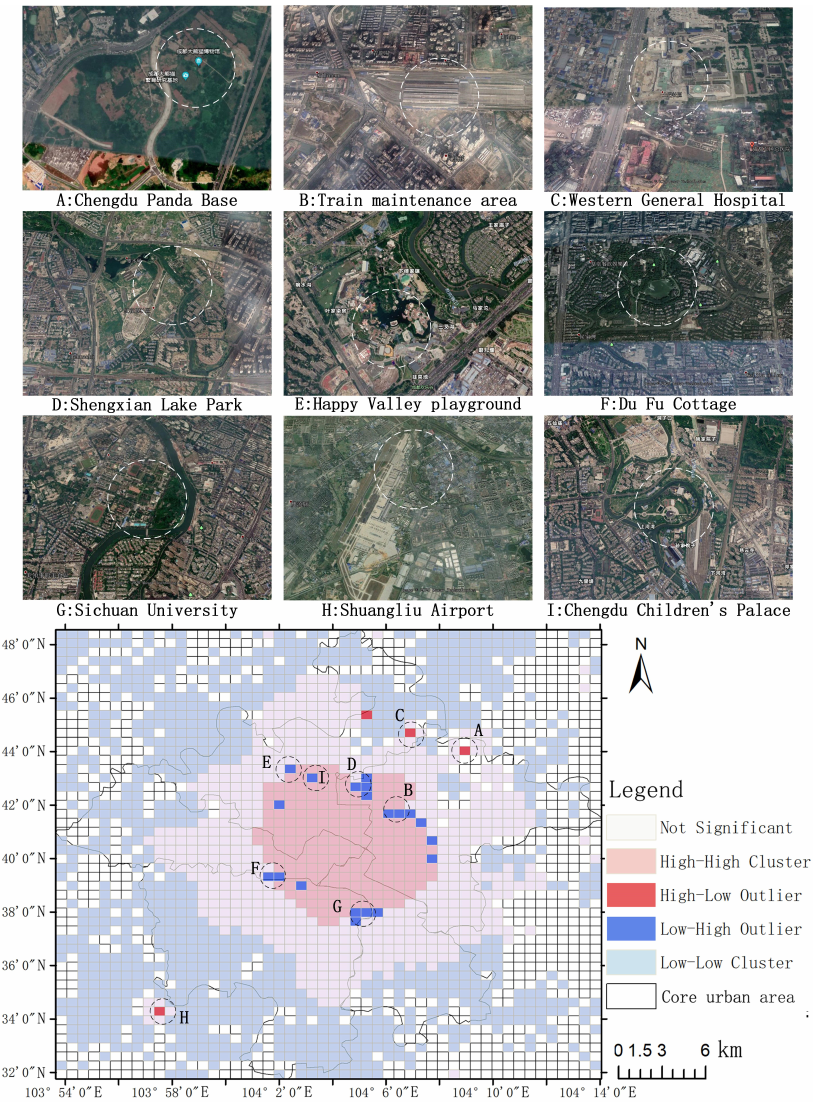
Figure 7. Spatial clustering and outlier analysis. (The above subplot is the remote sensing image of each clustering area, and the following subplot is the spatial detection